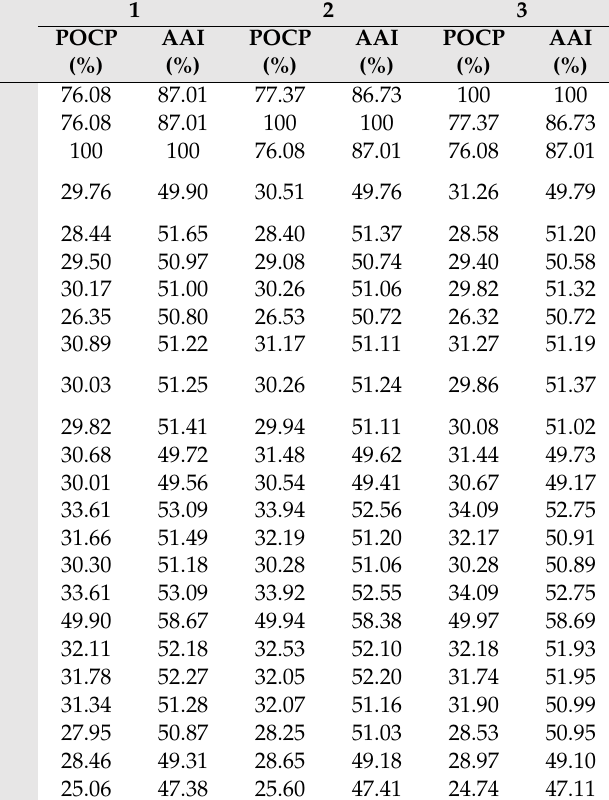
Table 4. Genome relatedness between the strain WH53 T and the other related type strains according to the average amino acid identity (AAI) value and the percentage of conserved proteins (POCP) value. Strains: 1, Zooshikella